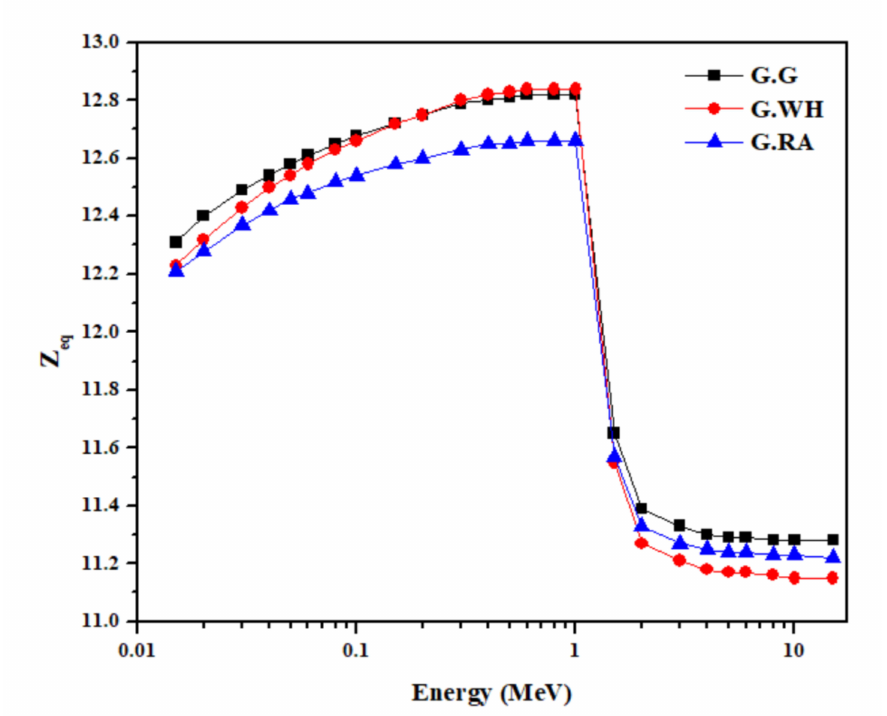
Figure 6. Variation of the calculated values of equivalent atomic number (Z eq ) with photon energy for the granite samples in the energy range 0.015 to 15